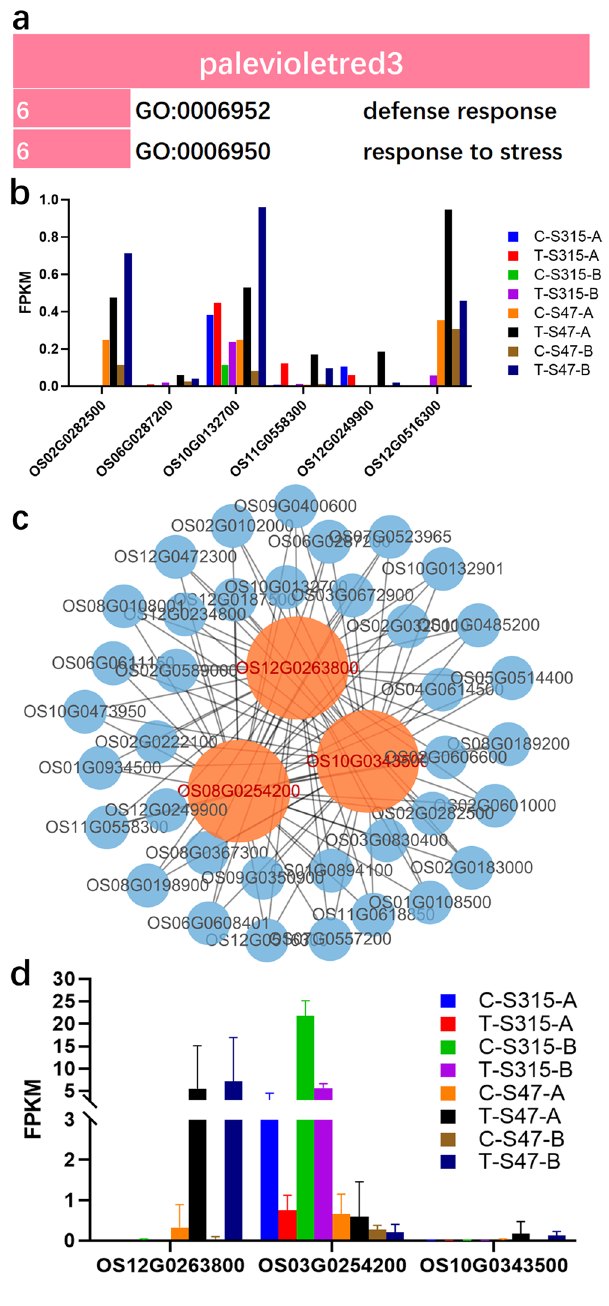
Figure 6. The modules associated with Cd treatment. ( a ) the Gene Ontology biological processes (GO-BP). ( b ) expression of enriched DEGs in GO term “defense response”. The number ahead of the items indicates the gene number. ( c,d ) gene interaction network and the expression profiles of key regulators in the interaction network. The bigger the node, the greater the number of connections it has. Nodes with different colors are with different number of